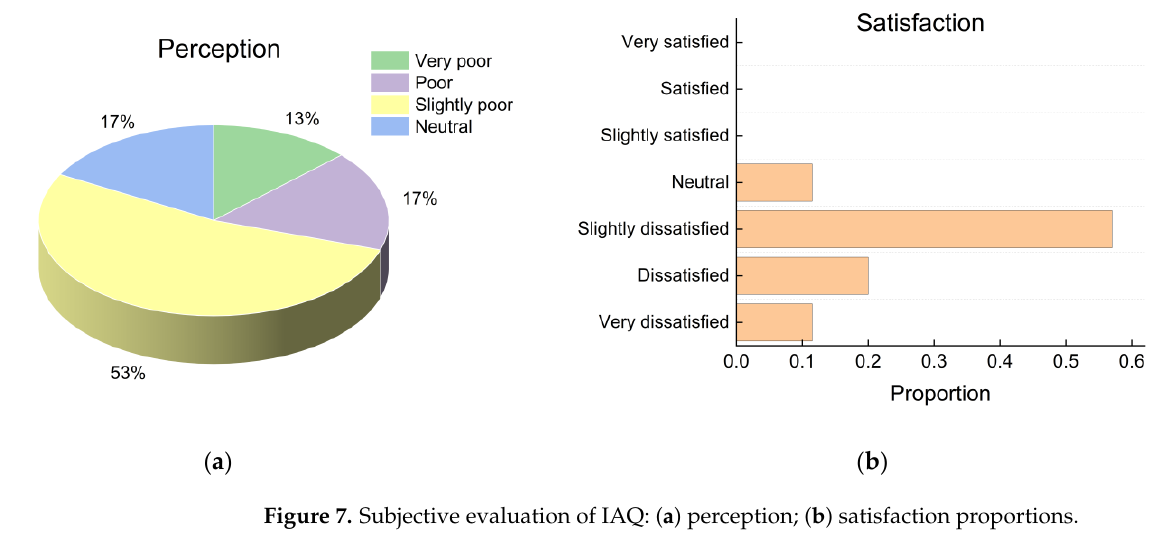
Figure 7. Subjective evaluation of IAQ: ( a ) perception; ( b ) satisfaction proportions.